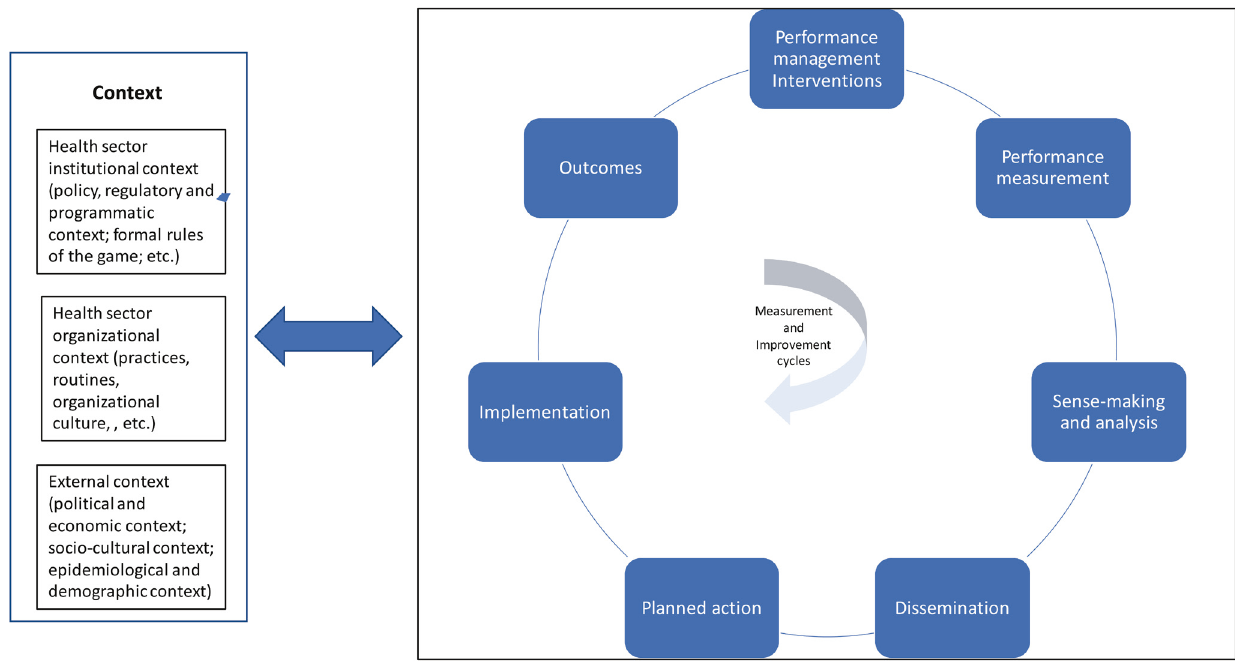
Figure 1. Generic performance measurement and management